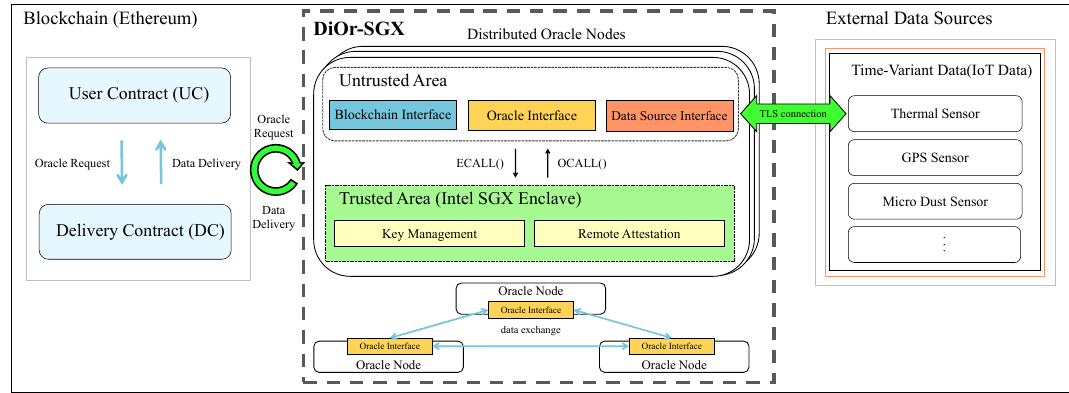
Figure 4. Overall Architecture of DiOr-SGX.